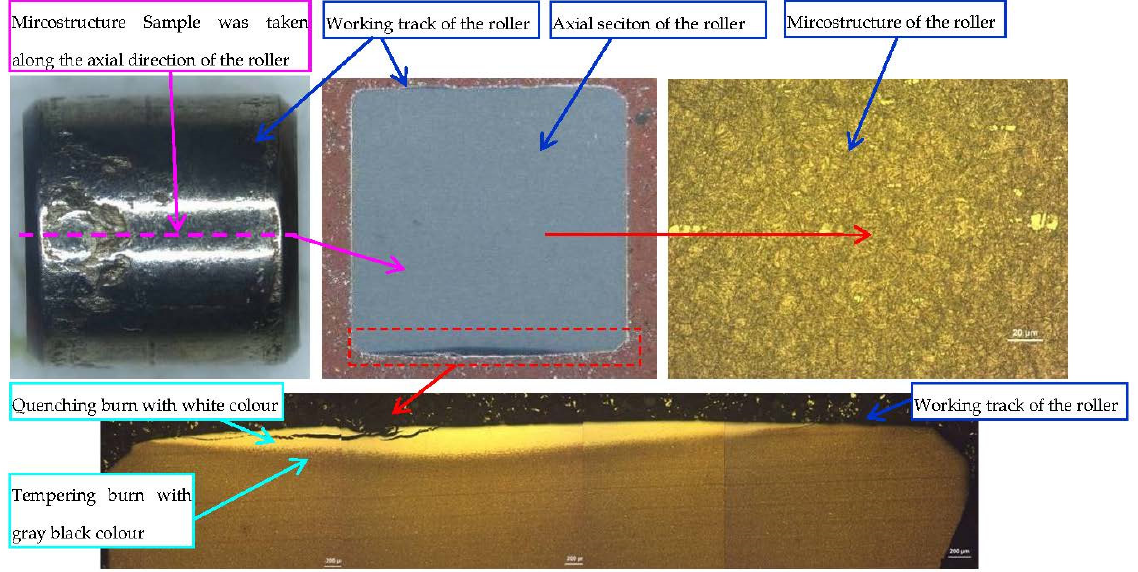
Figure 17. Typical microstructure and burns of the outer ring. The microstructure of the inner ring was a homogeneous structure and consisted of acicular martensite + carbide. The microstructure of the cage was a homogeneous struc- ture and consisted of tempered sorbite.